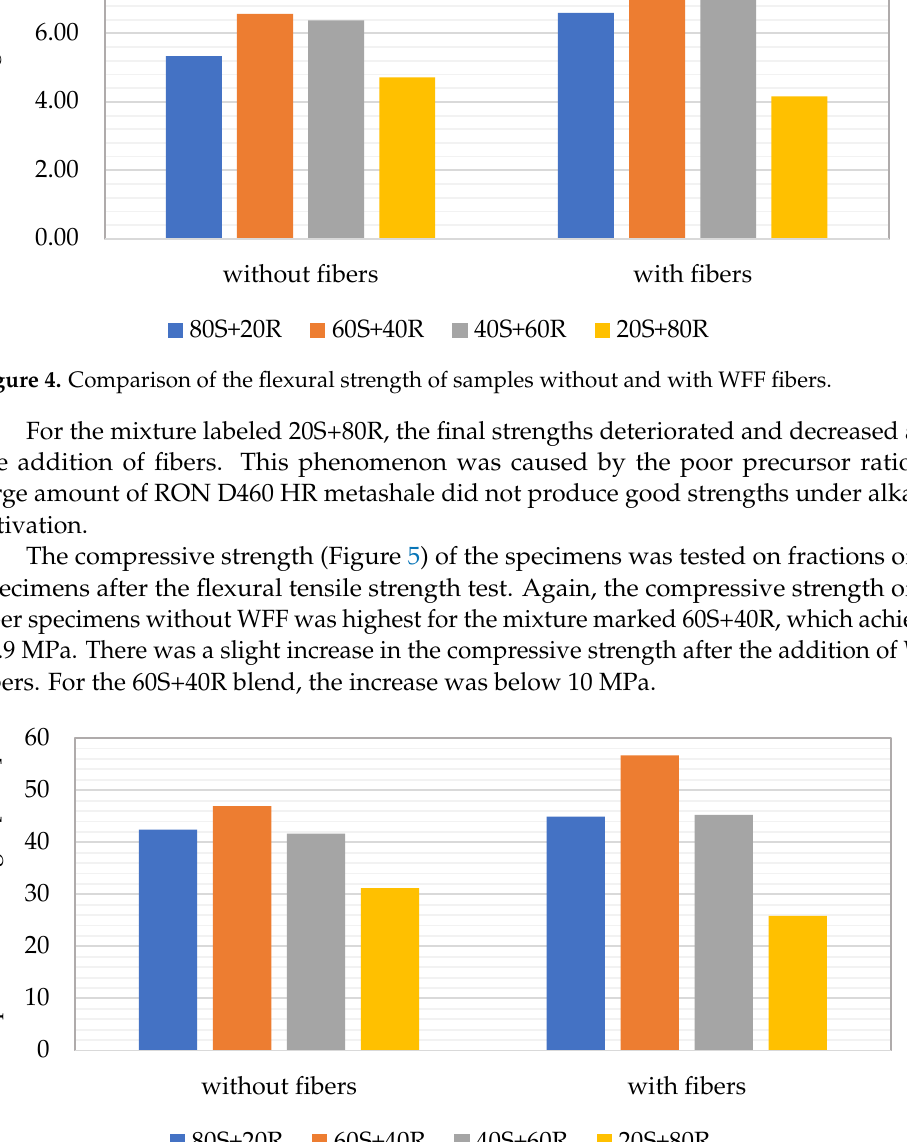
Figure 5. Comparison of the compressive strength of samples withoutand with WFF fibers.